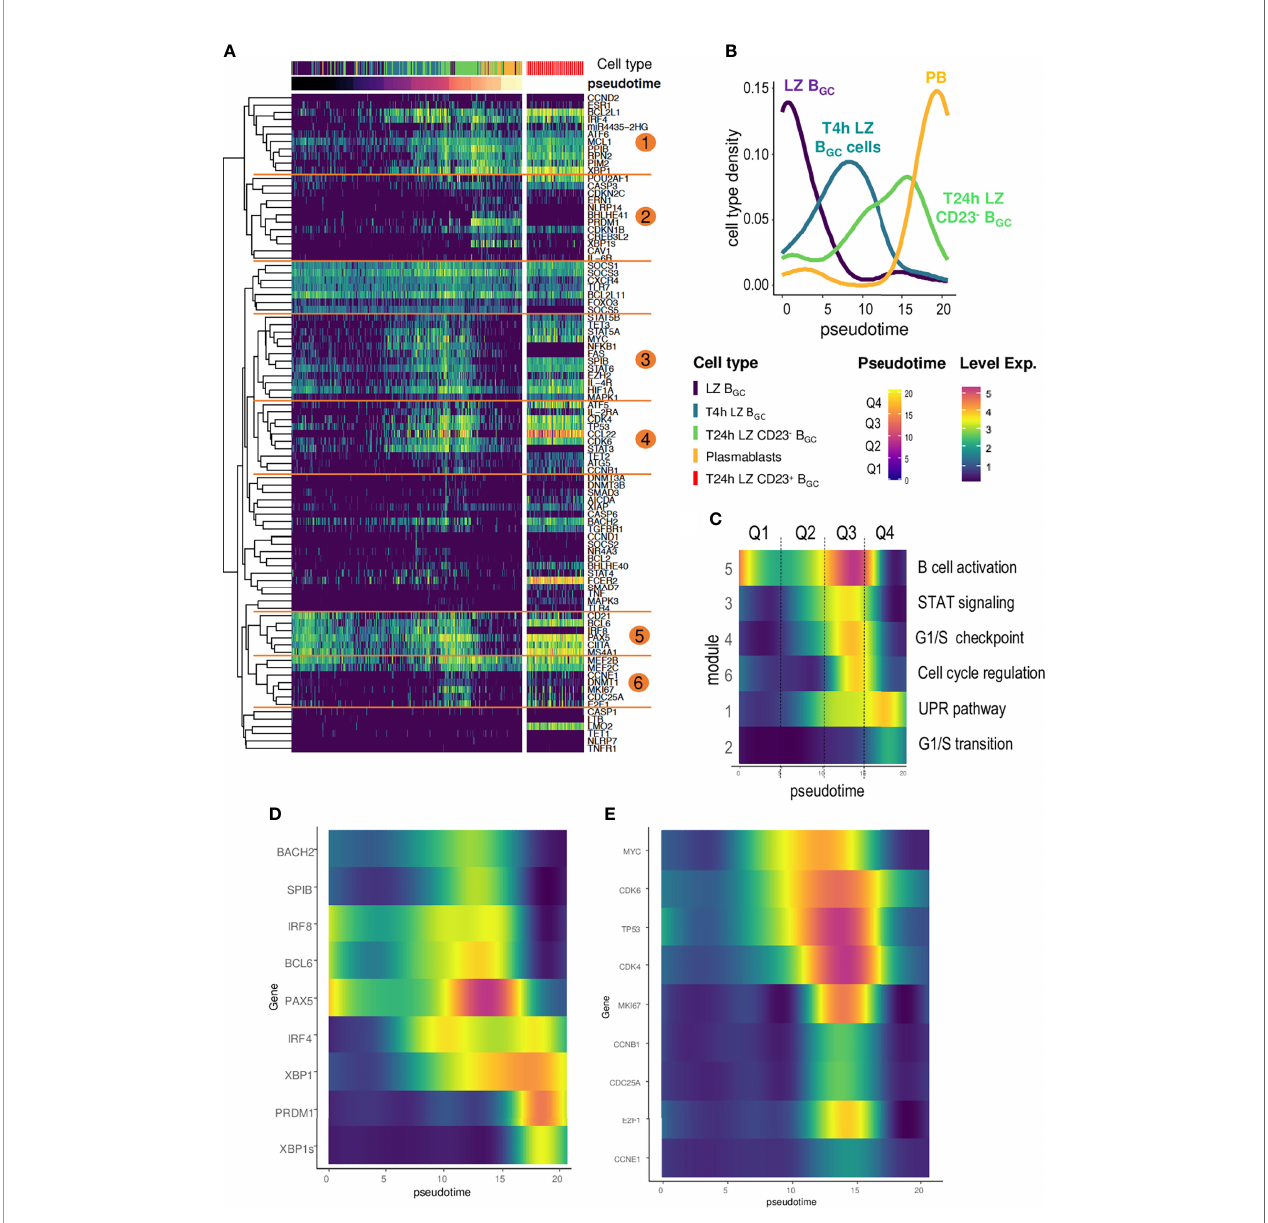
FIGURE 6 | The time course of gene analysis during LZ B GC -cell differentiation. (A) A heatmap computed for Monocle-ordered cells (LZ B GC -cells, PBs, T4h LZ B GC -cells, T24h CD23 + LZ B GC -cells, and CD23 - LZ B GC -cells), showing six different gene modules annotated with GeneMANIA. The pseudotime scale was calculated from the gene expression data. (B) Density of cell subsets in each quadrant of the pseudotime. (C) Smooth analysis of the time course of each module by pseudotime quadrant (Q1 to Q4) for all cell subsets except T24h CD23 + LZ B GC -cells. (D) The time course of gene expression during B cell activation and differentiation into PCs showing (i) a bimodal expression of IRF4 , (ii) a striking peak for PAX5 , (iii) PRDM1 elevation synchronized with PAX5 decline, and (iv) the speci fi c expression of XBP1s in the last quadrant of the pseudotime compared to XBP1 . (E) Gene expression during the differentiation of CD23 - LZ B GC -cells for Monocle-ordered cells showing a sequential transition from LZ B GC -cells to PBs for MYC expression, MYC-target genes and gene involved in cell cycle